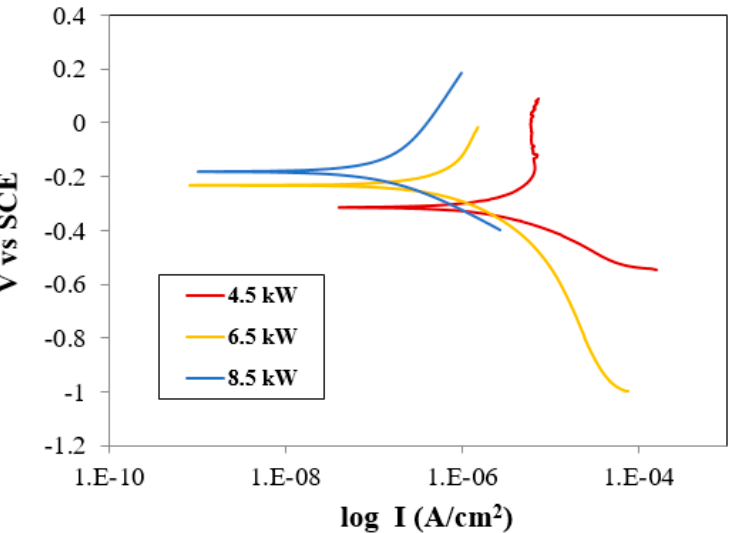
Figure 4. Potentiodynamic polarization diagram of 2205 duplex stainless steel welded with different pulse energy conditions.